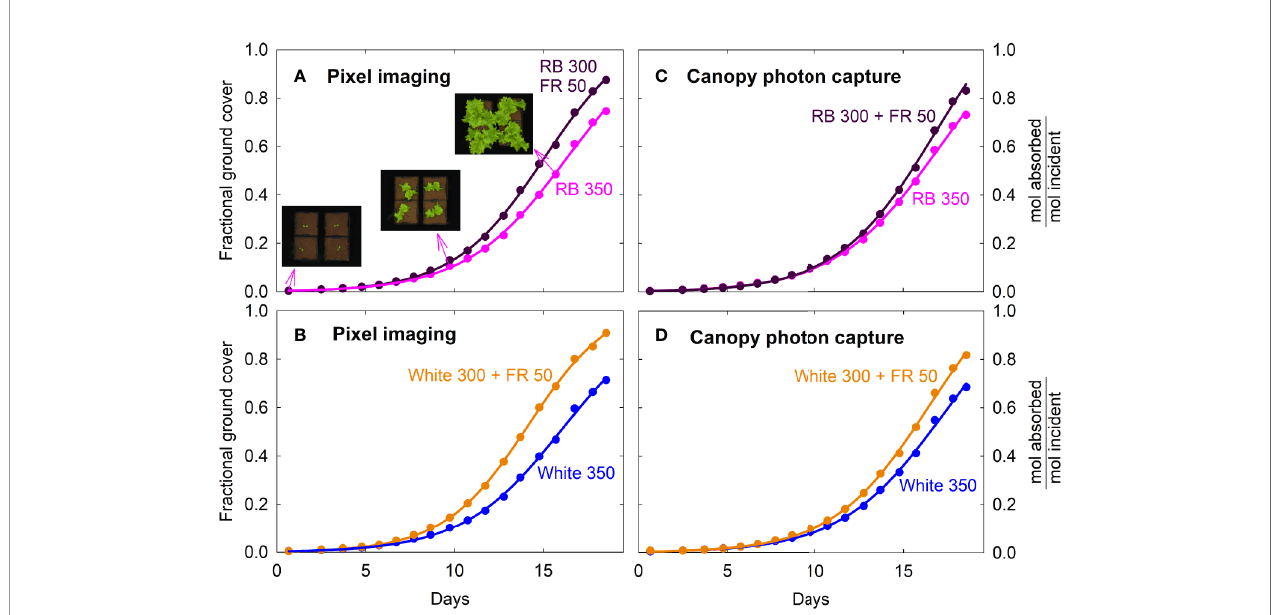
FIGURE 5 | Fraction of ground cover and canopy photon capture of lettuce under four spectral treatments. Fraction of ground cover was obtained from green pixel analysis of top down photos of the canopies. Canopy photon capture (moles of photon absorbed from 400 to 750 nm per mole of incident photons) was estimated from ground cover, leaf photon absorption of the incident spectra and leaf area index. RB, red and blue; FR, far-red. The numbers following each type of light ( e.g. RB 350) indicate photon fl ux density in m mol m − 2 s − 1